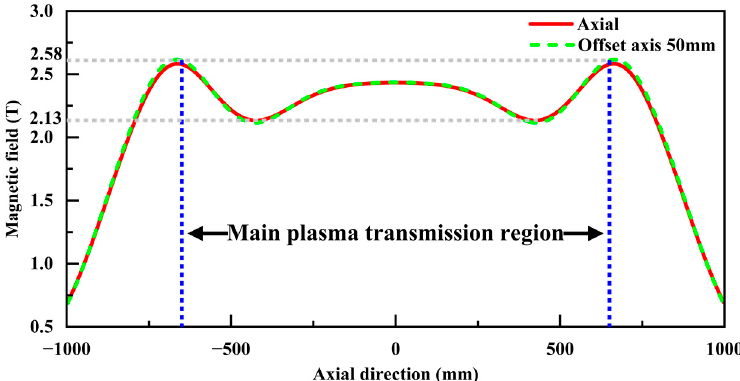
Figure 7. The calculated magnetic field strength on the axis with an average of 2.31 T in the main plasma transmission region .